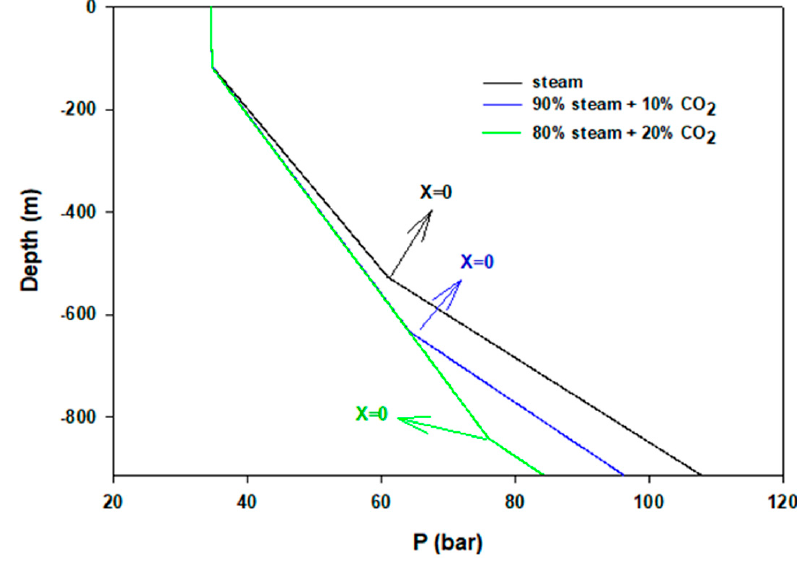
Figure 7. Temperature distributions of two different injecting velocities.